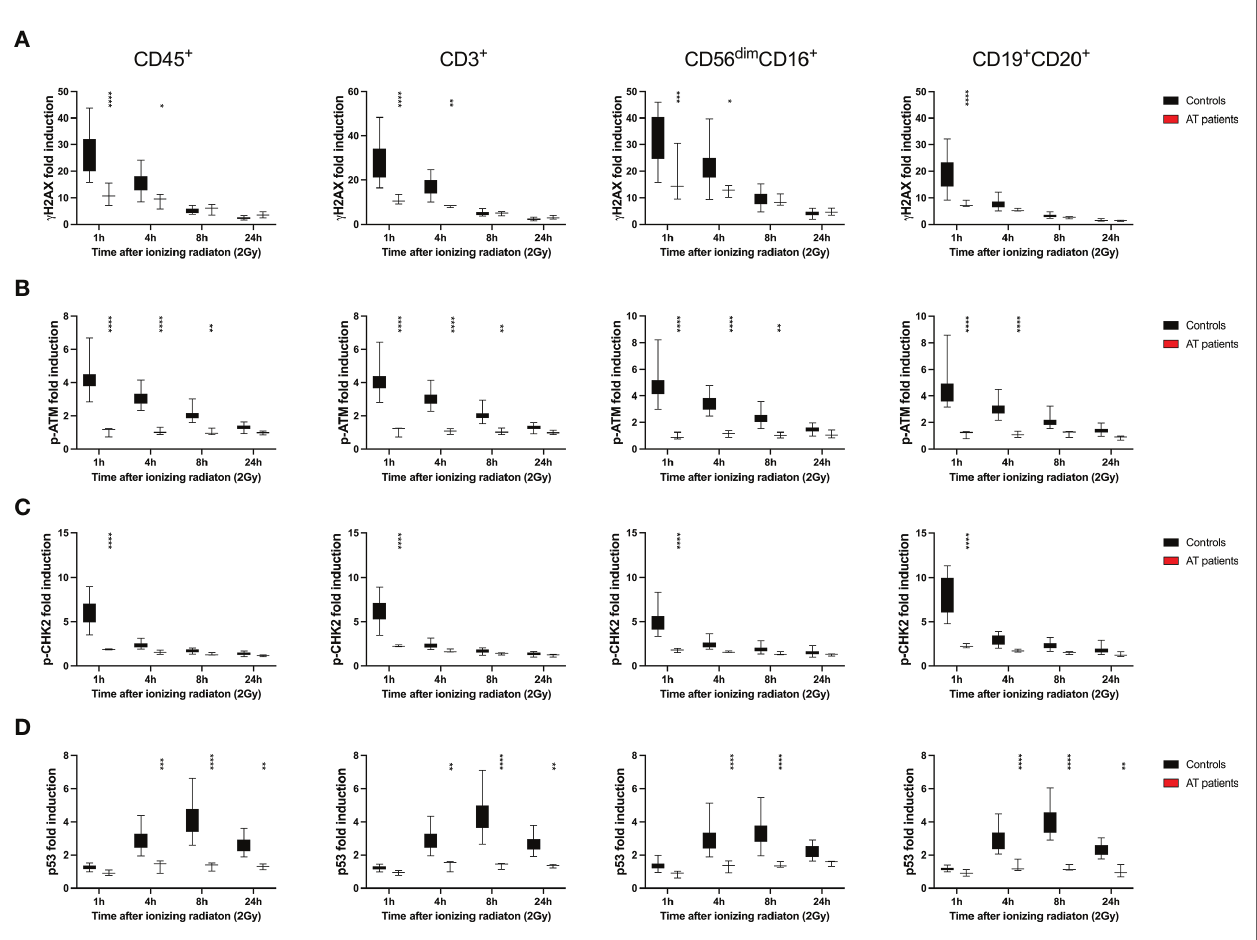
FIGURE 9 | DDR is diminished in all lymphocyte subsets of patients with ataxia telangiectasia. PBMCs obtained from healthy donors and 3 patients with ataxia telangiectasia (AT) were treated with 2Gy ionizing radiation and fi xed after 1h, 4h, 8h and 24h. Fold inductions of g H2AX (A) , p-ATM (B) , p-CHK2 (C) , and p53 (D) were calculated in CD45 + , CD45 + CD3 + , CD45 + CD3 - CD56 dim CD16 - , and CD45 + CD3 - CD19 + CD20 + lymphocyte subsets, based on mean fl uorescence intensities normalized on unirradiated samples. Box plots indicate distribution of fold inductions obtained from 26 healthy donors and 3 AT patients; error bars represent standard deviations. Signi fi cance is shown for differences between controls and patients (*p ≤ 0.05, **p ≤ 0.01, ***p ≤ 0.001, ****p ≤